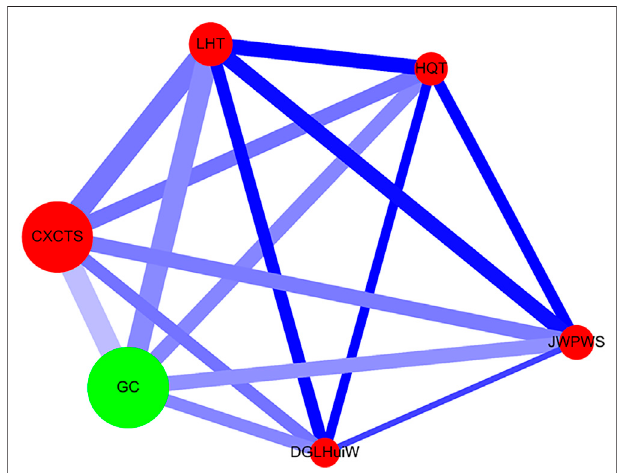
FIGURE 3 | Network analysis for CHM prescription pattern in HIV- infected patients with osteoporosis or fractures. The lines connecting CHMs represent the support value: thicker lines represent higher support values (Support (X) (%)). The line color between CHMs shows the lift value: darker lines represent stronger connections with higher lift values. The red circle represents herbal formulas, while the green circle represents single herbs. The size of the circle for each CHM shows its prescription frequency: larger circles indicate higher prescription frequency. Support (X) (%) (cid:1) Frequency of prescriptions of X and Y products/total prescriptions x 100%. Lift (cid:1) Con fi dence(X → Y)(%)/P (Y)(%).Con fi dence (X → Y)(%) (cid:1) Frequency of prescriptions of X and Y products/Frequency of prescriptions of X product x 100%.P(Y)(%) (cid:1) FrequencyofprescriptionsofYproduct/totalprescriptionsx